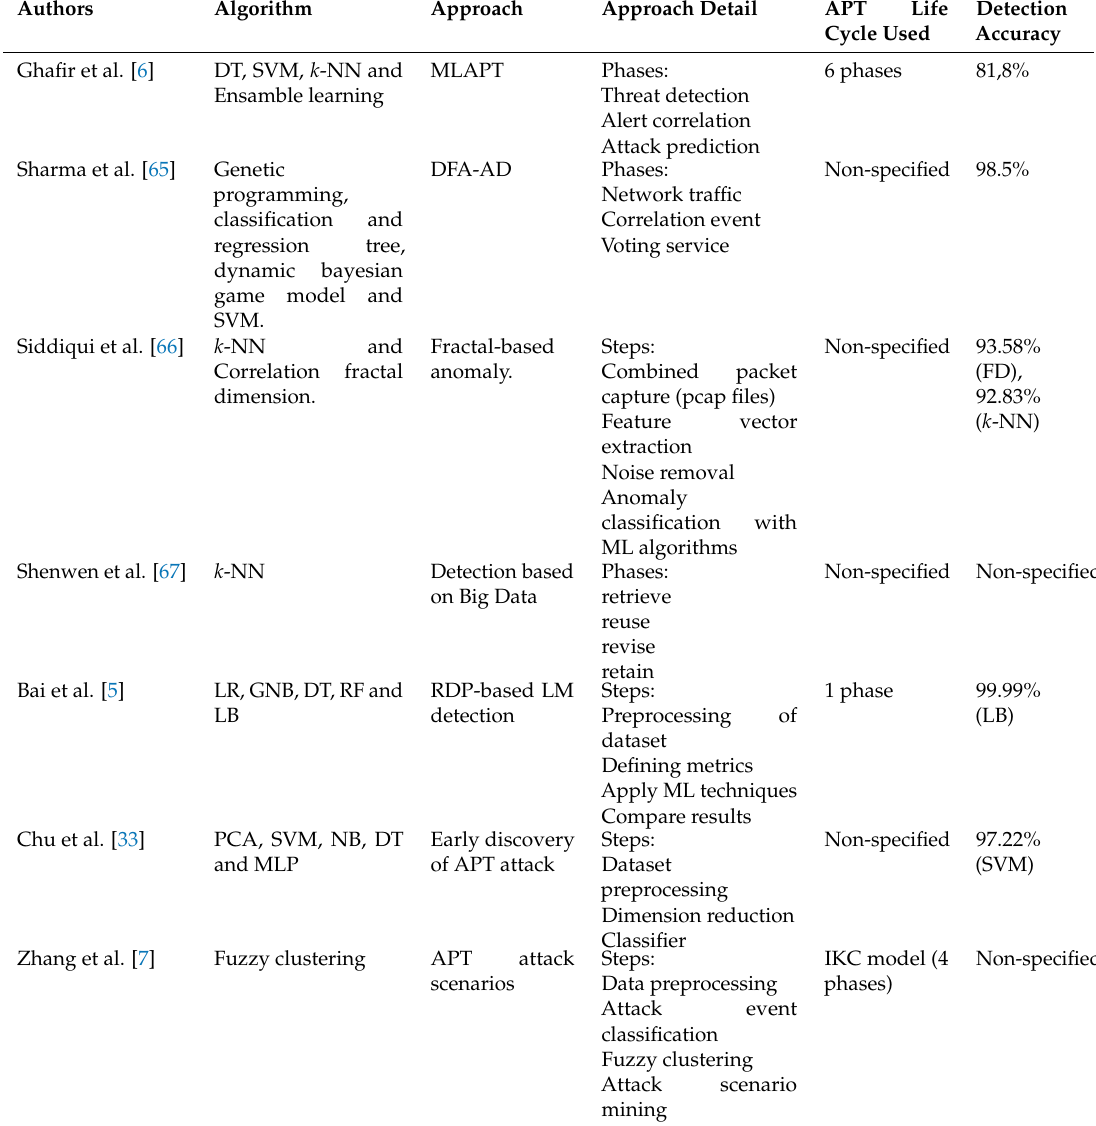
Table 3. Comparison of machine learning (ML)-based APT detection